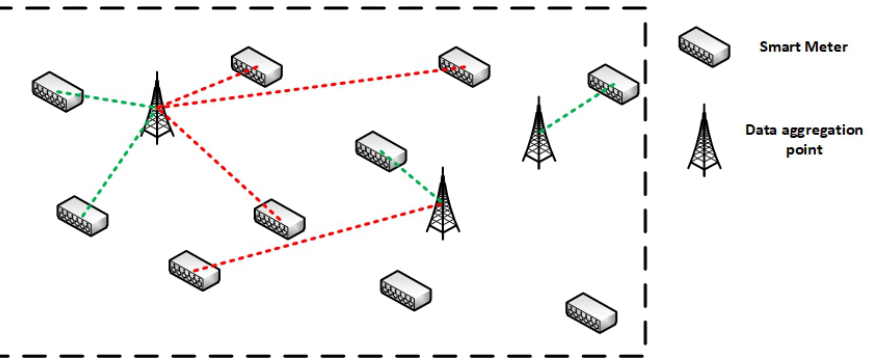
Figure 1. Network Topology of Advanced Metering Infrastructure